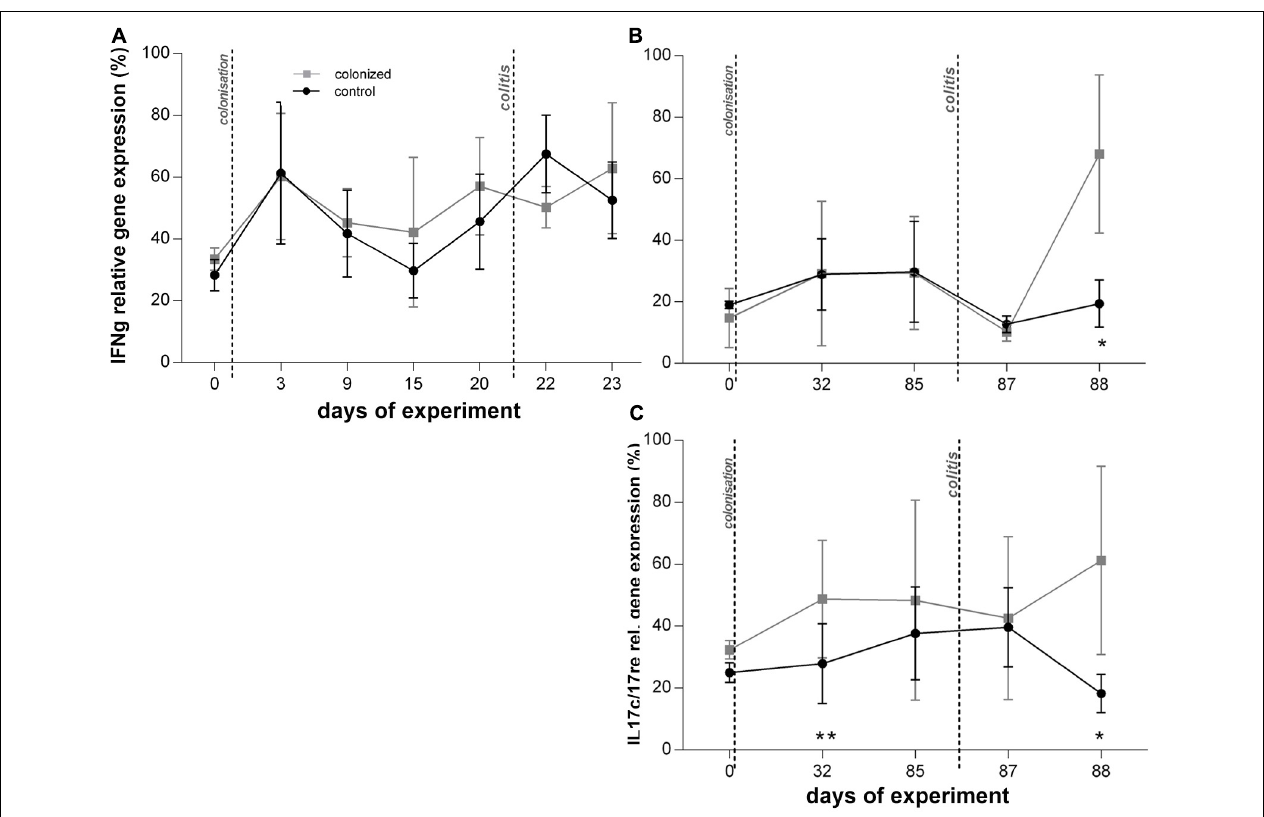
FIGURE 4 | Graphical visualization of the relative gene expression of other measured cytokines over the course of the Blastocystis ST3 colonization and colitis induction. Blastocystis colonized group is in gray squares, control group in black dots. All cytokines are measured to UBC housekeeping gene. (A,B) IFN γ gene expression relative – (A) during the short-term colonization (3 weeks), (B) during the long-term colonization (13 weeks); (C) IL17re/IL17C gene expression relative during the long-term colonization only. Differences between groups calculated with Welch’s t -tests followed by Benjamini–Hochberg correction. Error bars are standard errors; * P = 0.05–0.01, ** P = 0.01–0.001. *** P <